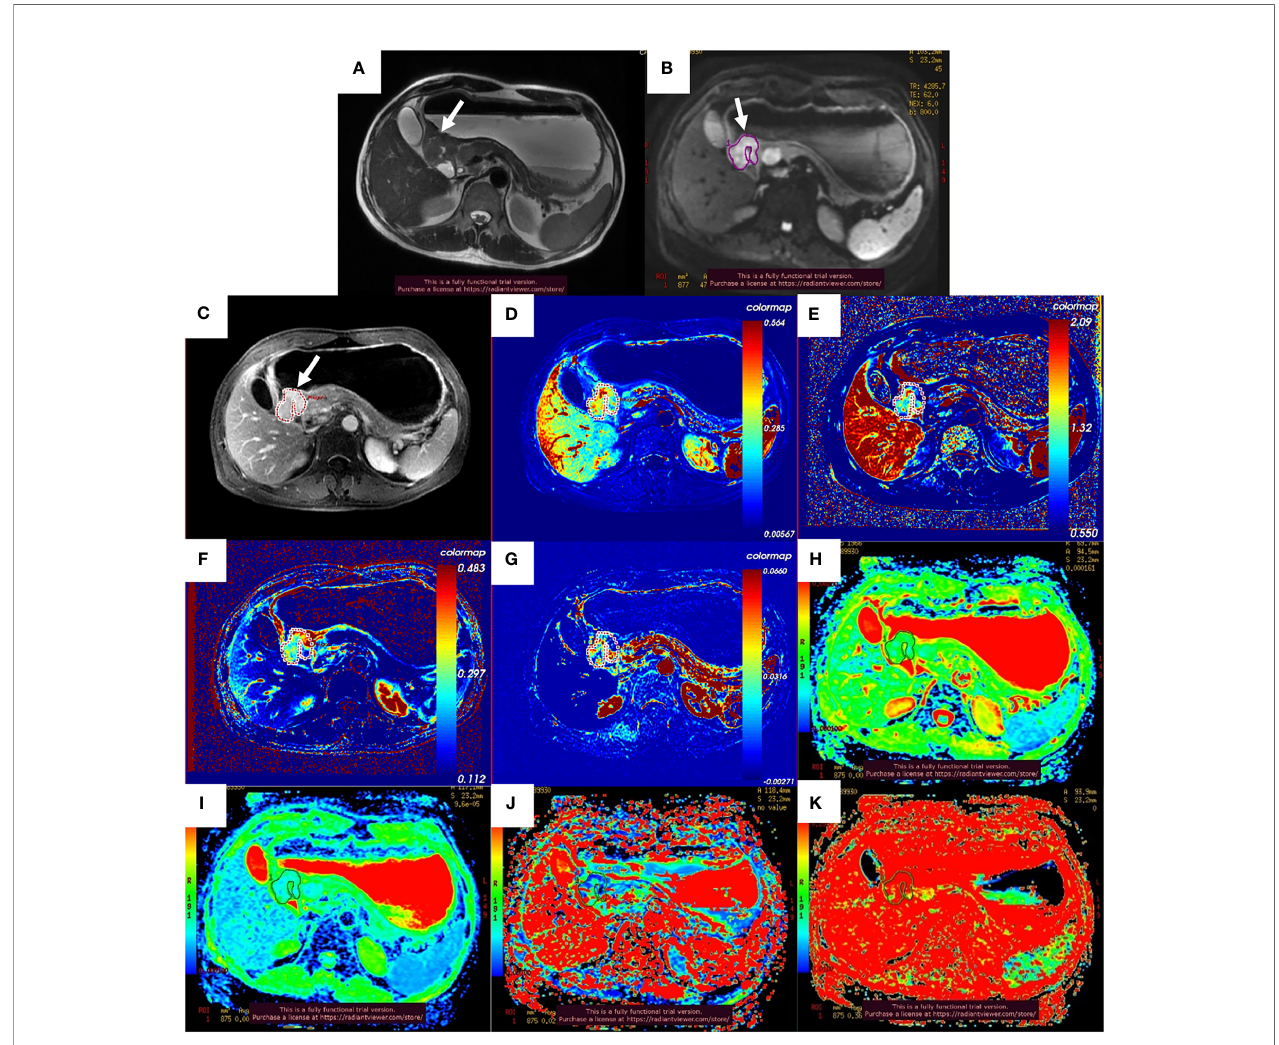
FIGURE 2 | Images of a 51-year-old man with gastric adenocarcinoma in the antrum of the stomach who had response to NCT. In T2WI (A) , IVIM-DWI (B) , and contrast-enhanced imaging (C) , the gastric wall was irregularly thickened with high signal intensity, diffusion restricted, and heterogeneously enhanced (white arrows). The pseudo-colorized K trans maps (D) , k ep map (E) , v e map (F) , v p map (G) , ADC standard map (H) , D map (I) , D* map (J) , and f map (K) show mixed red, green, and blue colors in the corresponding tumor with a K trans of 0.298 min − 1 , k ep of 1.086 min − 1 , v e of 0.303, v p of 0.027, ADC standard of 1.330 × 10 − 3 mm 2 /s, D of 0.893 × 10 − 3 mm 2 /s, D* of 24.000 × 10 − 3 mm 2 /s, and f of 36.6%. NCT, neoadjuvant chemotherapy; T2WI, T2-weighted imaging; IVIM-DWI, intravoxel incoherent motion diffusion-weighted